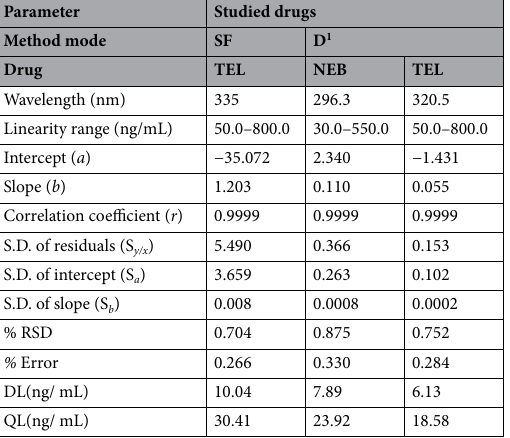
Parameter Studied drugs Method